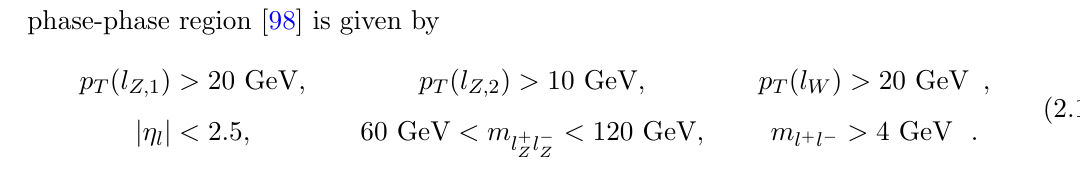
Figure 3 . The di(cid:11)erential distributions of m channel at the LHC at p s = 13 TeV and L = 35 : 9 fb (cid:0) 1 at NLO in QCD for SM and (cid:12)ve benchmark anomalous